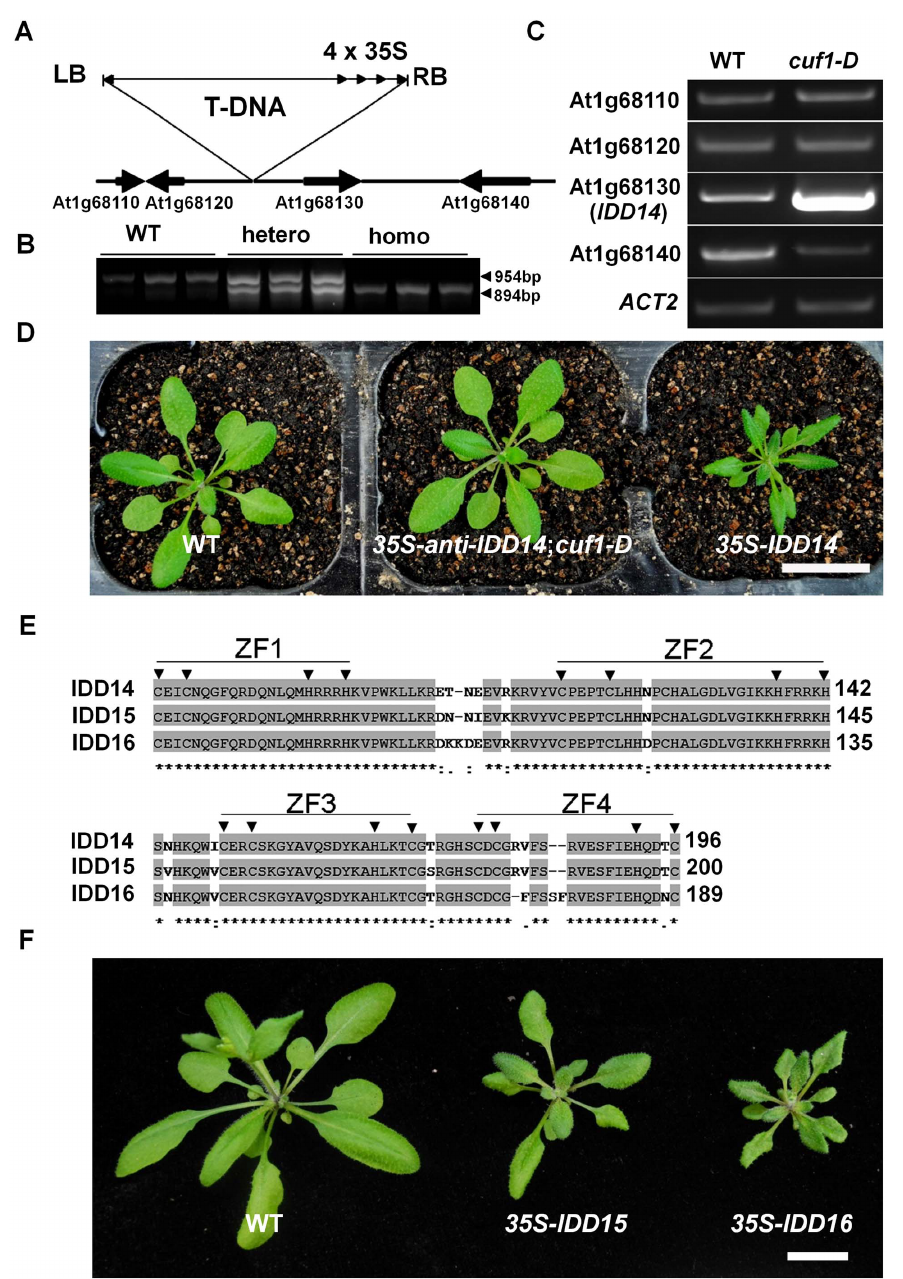
Figure 2. Molecular characterization of CUF1 / IDD14 . (A) Scheme of the genomic region flanking T-DNA insertion in cuf1-D . Genes are shown as thick arrows and intergenic regions are shown as lines. The orientation of T-DNA left border (LB), right border (RB), and the four CaMV 35S enhancers (4 6 35S) are indicated. (B) Linkage analysis of the T-DNA and cuf1-D phenotype. The 954-bp genomic fragments in WT and cuf1-D/ + plants were amplified with primers in the genomic region flanking the T-DNA insertion site, and the 894-bp fragments in cuf1-D/ + and cuf1-D were amplified with an LB primer and a downstream genomic primer. (C) Expression analysis of the genes flanking the T-DNA in WT and cuf1-D plants. ACTIN2 ( ACT2 ) was used as an internal control. Note that transcripts of At1g68130 ( IDD14 ) are highly elevated in cuf1-D . (D) Morphology of 25-days-old WT, cuf1-D carrying p35S::anti-IDD14 , and p35S::IDD14 plants. The scale bar represents 2 cm. (E) Alignment of the ID domains in IDD14, IDD15, and IDD16. ZF1- ZF4 represents the four C2H2-type zinc finger motifs. The arrowheads indicate the conserved cysteine and histidine residues. (F) Morphology of 4- week-old transgenic plants overexpressing IDD15 or IDD16 . The scale bar represents 1 cm.